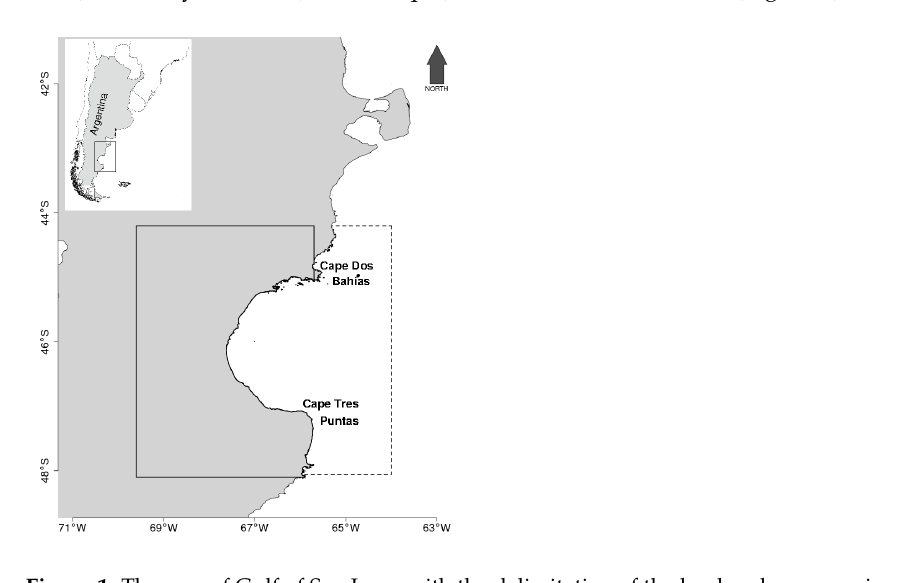
Figure 1. The area of Gulf of San Jorge with the delimitation of the land and ocean regions where the MMI algorithm has been